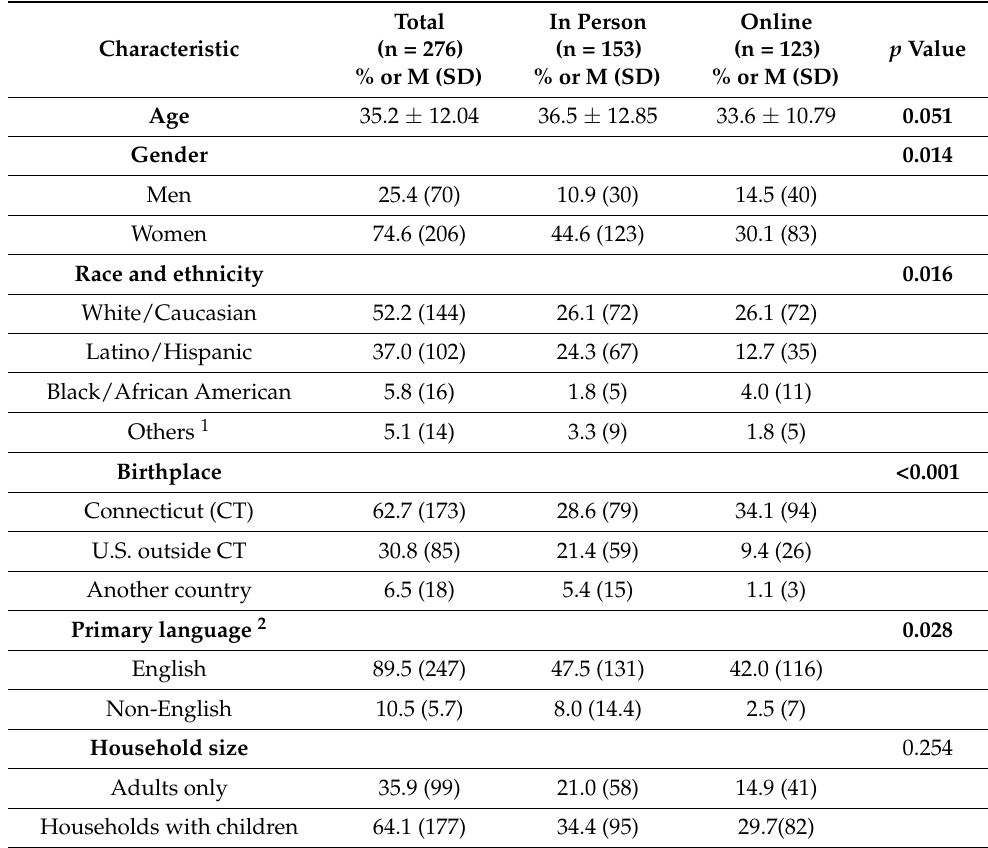
Table 1. Sociodemographic, lifestyle, and health characteristics of adults who live in a community of low-income and low-access to healthy food community in Northeast Connecticut by reported use of ordering groceries